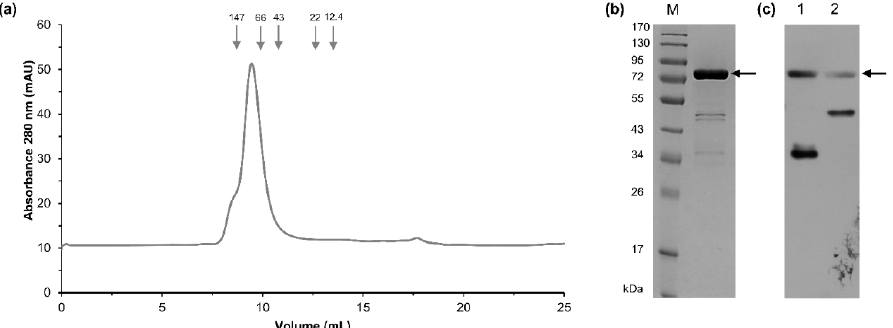
Figure 4. Analysis of Tt72 pol degradation products. ( a ) Size-exclusion chromatography elution profile of Tt72 pol on a Superdex 75 10/300 GL column (GE Healthcare). Tt72 pol (0.5 mg) sample was loaded on the column equilibrated with 50 mM potassium phosphate buffer (pH 7.0), 150 mM NaCl, and eluted at a flow rate of 0.5 mL/min in the same buffer. The column was calibrated with proteins of known molecular masses: alcohol dehydrogenase (tetramer), 146.8 kDa; bovine serum albumin, 66 kDa; ovalbumin, 43 kDa; trypsin inhibitor, 22 kDa; and cytochrome C, 12.4 kDa (Sigma-Aldrich, St. Louis, MO, USA). ( b ) Eluted protein with His-tag at the N -terminus was analyzed by 10% SDS-polyacrylamide gel electrophoresis and stained with Coomassie Brilliant Blue. Lane M, protein molecular mass standards (PageRuler TM Prestained Protein Ladder, Thermo Scientific, Waltham, MA, USA). ( c ) Western blot analysis of the Tt72 pol with use of anti-His-tag antibodies. Lane 1, recombinant Tt72 pol with His-tag at N -terminus; lane 2, recombinant Tt72 pol with His-tag at C -terminus. An arrow indicates the position of the intact His-tagged Tt72 pol (82.7 kDa).